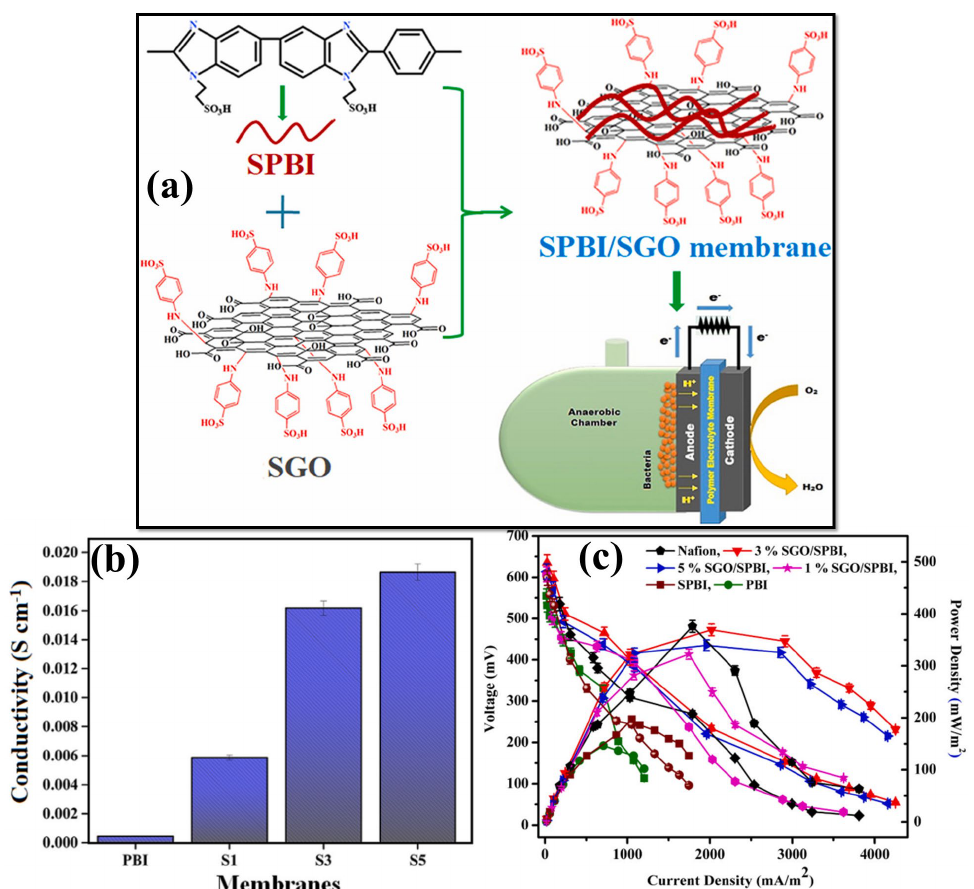
Figure 5. ( a ) A schematic representation of SPBI-SGO membrane preparation progression for MFC